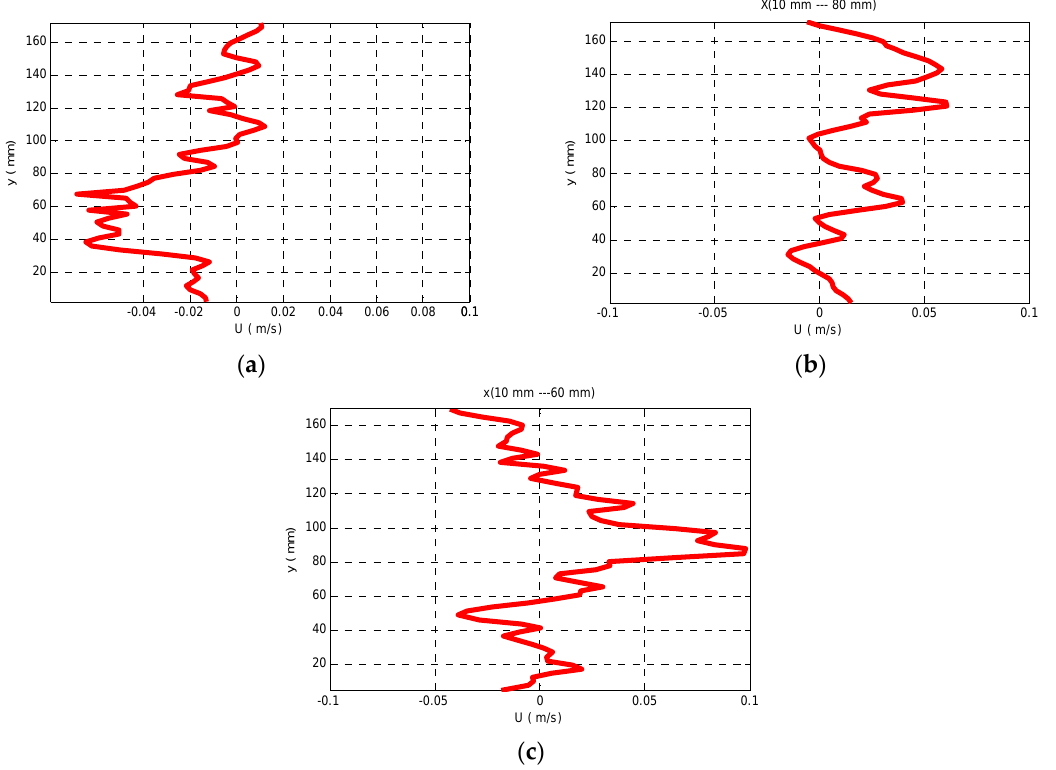
Figure 3. Velocity profiles upstream of the first mussel shock for velocity at the entrance of the channel ( a ) 5 cm/s, ( b ) 7 cm/s and ( c ) 9